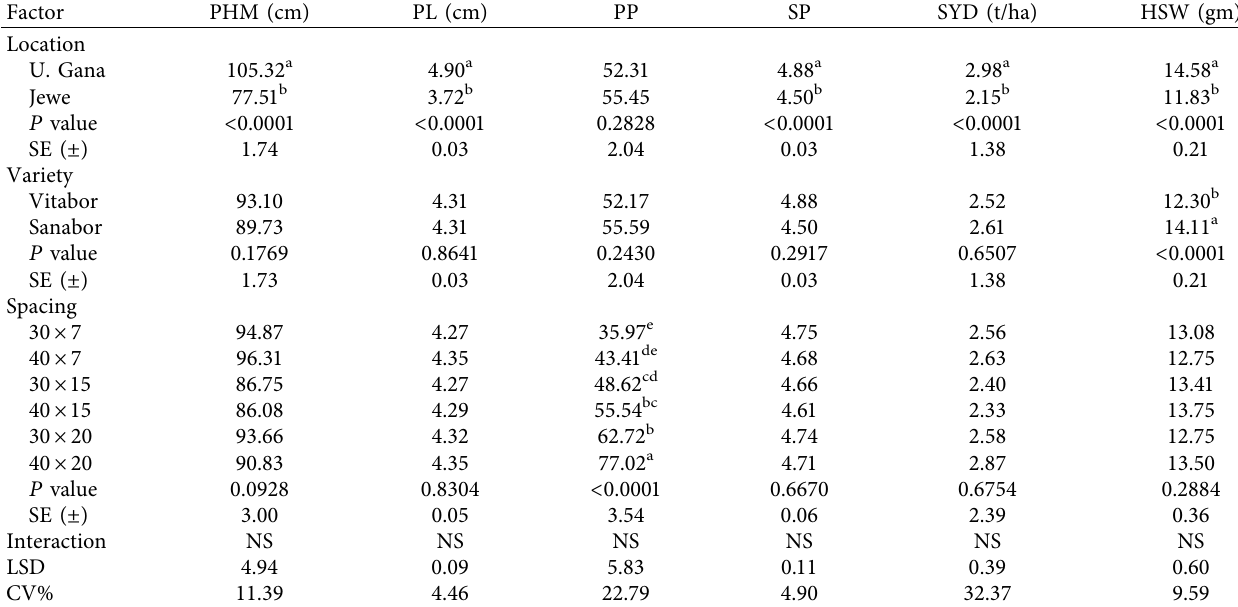
Table 6: Effects of location, spacing, and variety on plant height, pod length, number of pods per plant, number of seeds per pod, seed yield, and hundred seed